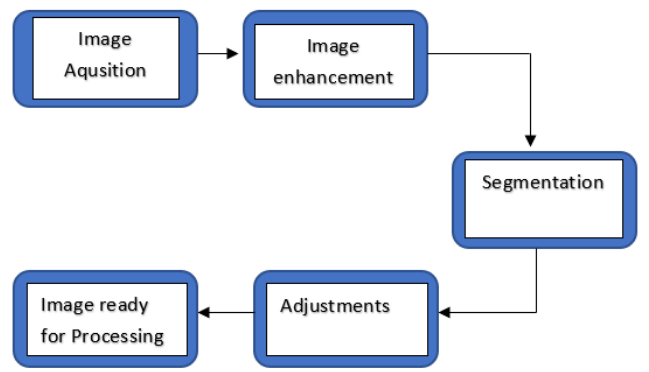
Figure 3. Image processing flow chart.